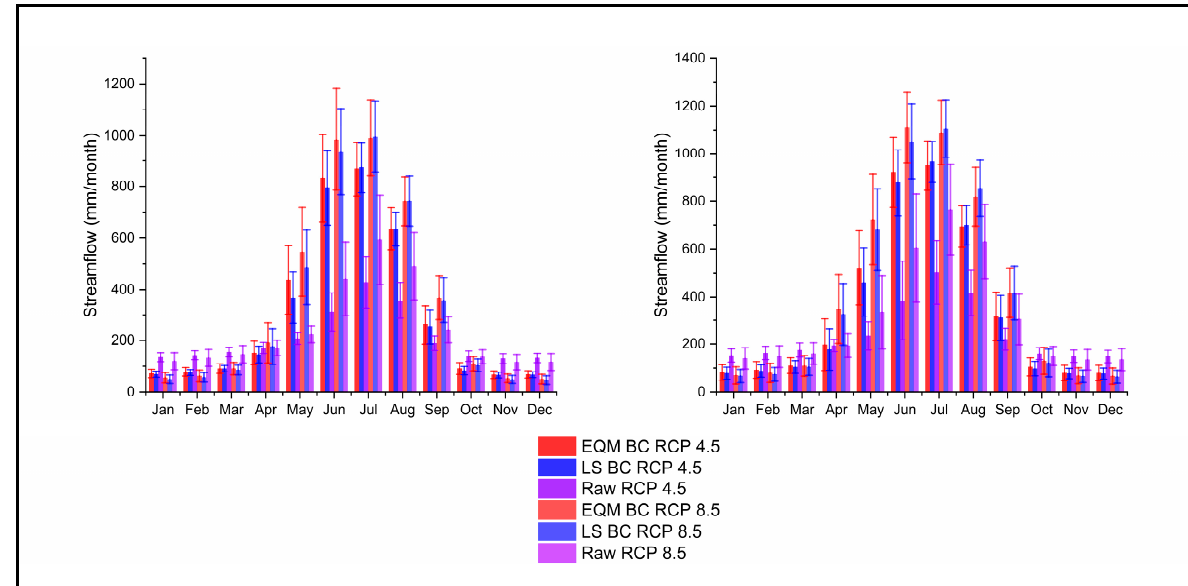
Figure 13. As Figure 8, but for the period 2070–2099.